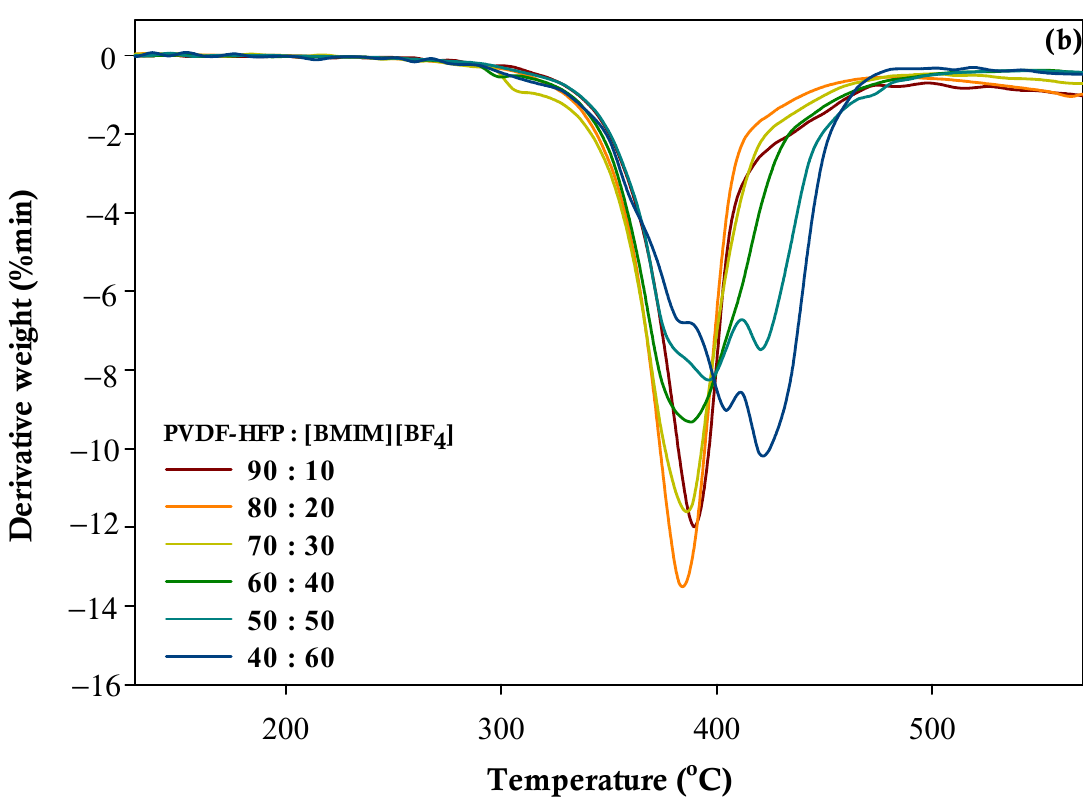
Figure 8. Thermogram of ( a ) TGA and ( b ) DTG of different percentage ratio of PVDF-HFP to [BMIM][BF 4 ].